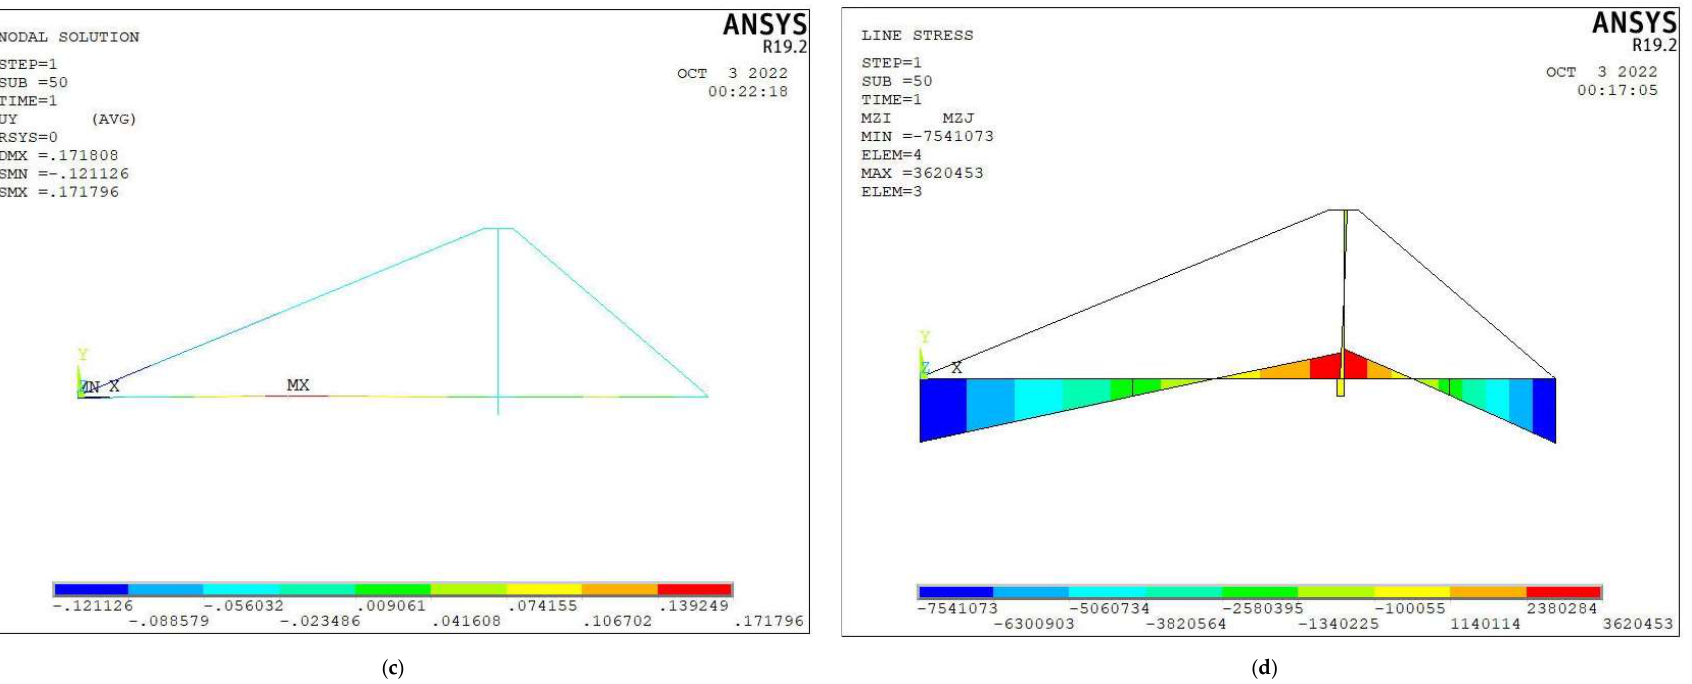
Figure 7. Calculation results of development element user101: ( a ) vertical displacement under condition 1; ( b ) bending moment under condition 1; ( c ) vertical displacement under condition 2; ( d ) bending moment under condition 2.